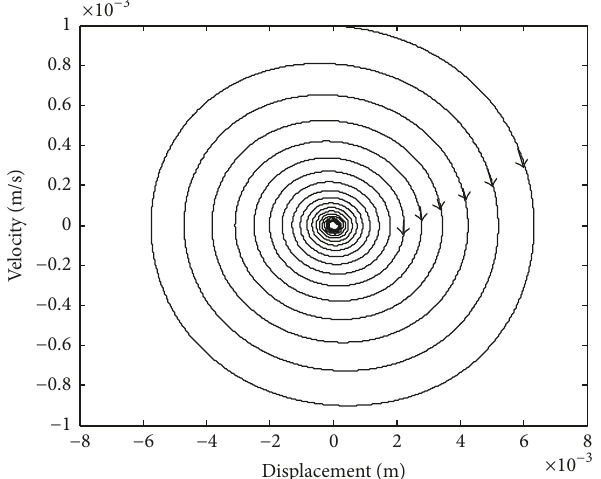
Figure 6: Numerical simulation for region (III), for ( 𝐾 1 , 𝐾 2 ) = ( − 0.02, − 0.01).